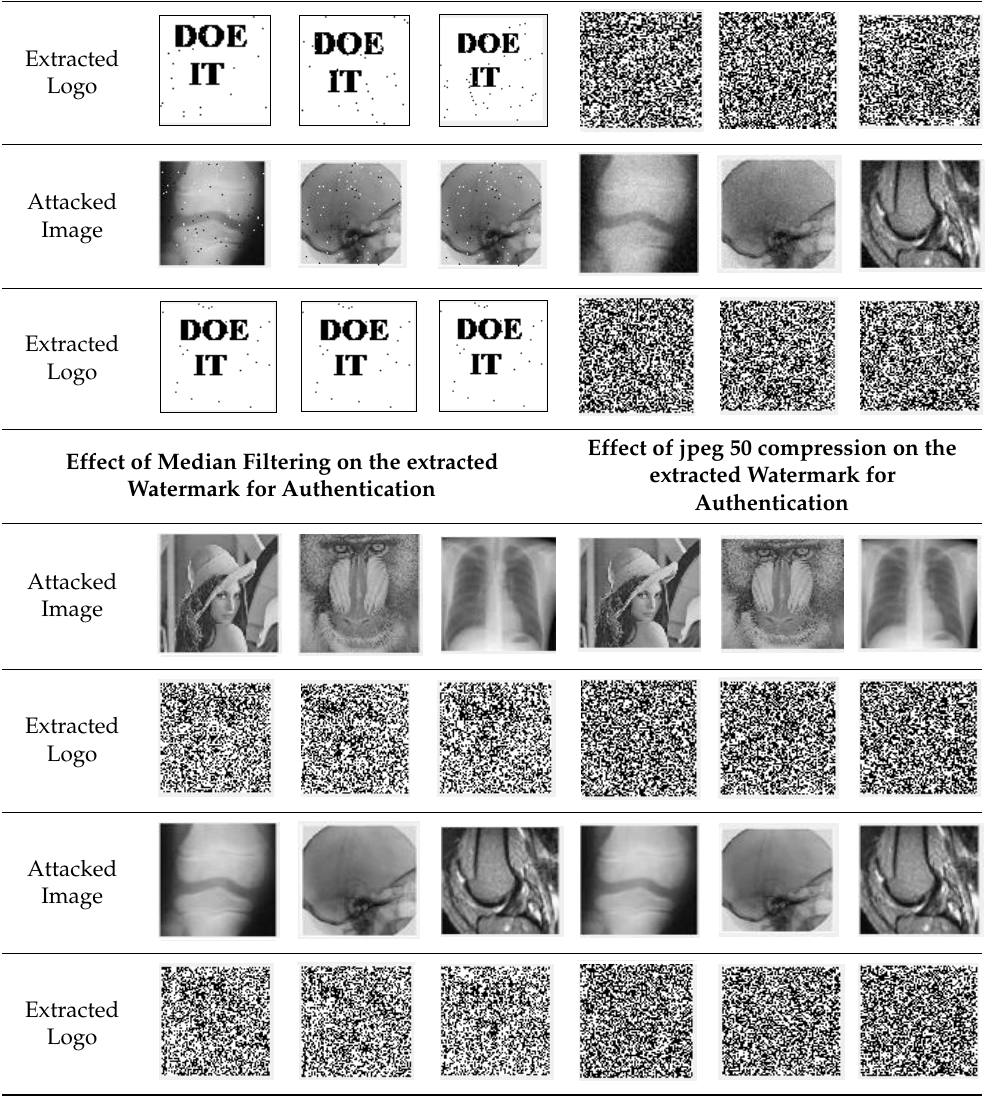
Table 4. Subjective quality images after various attacks. Effect of Salt and Pepper Noise on the Extracted